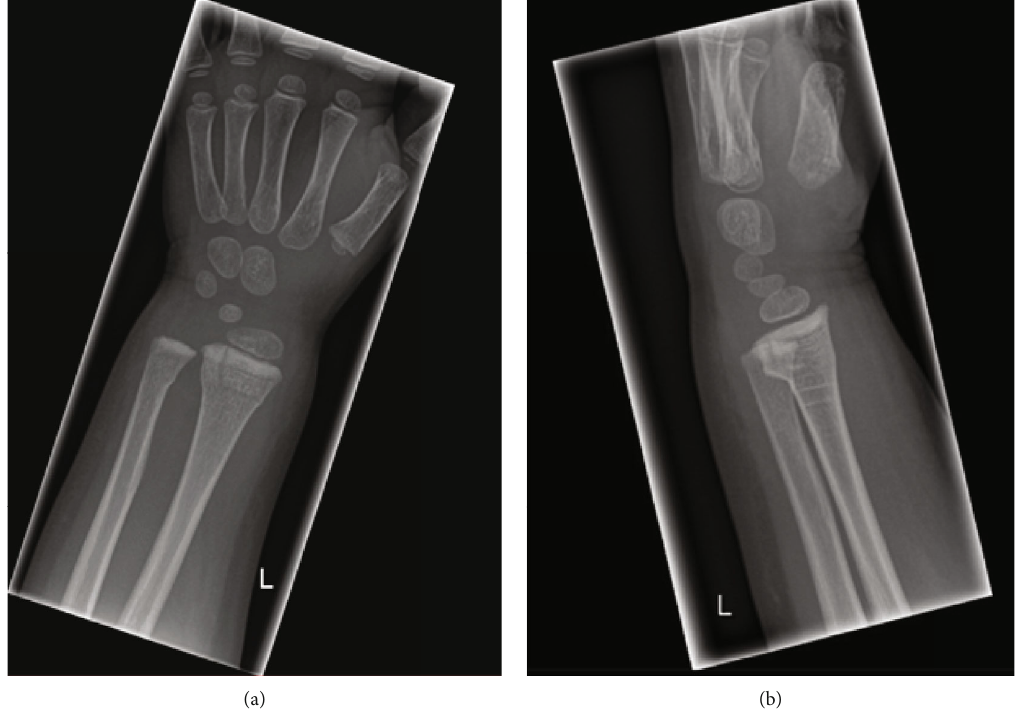
Figure 1: (a, b) Anteroposterior and lateral radiographs of the left wrist showing Salter-Harris type 2 fracture of the distal radius, with minimal dorsal displacement and a small line on the ulna suggestive for an ulnar fi ssure.